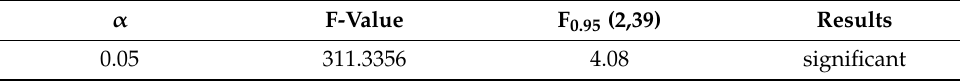
Table 3. Test of multiple linear regression model.